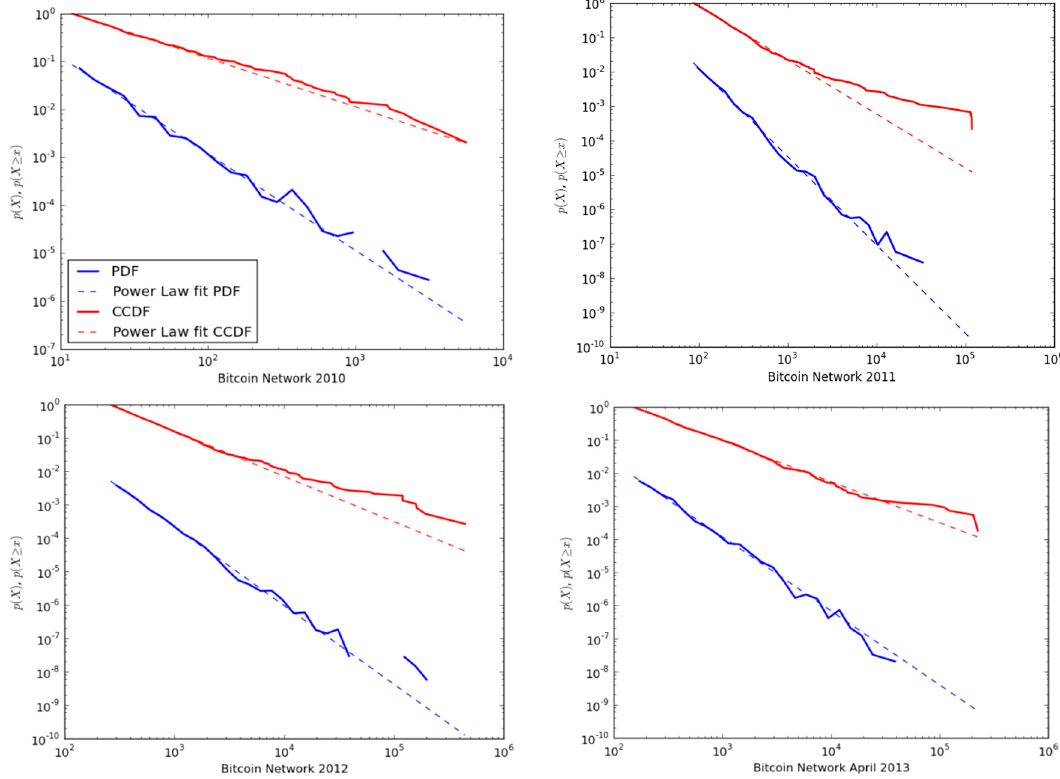
Figure 21. Degree Distribution (probability density function (PDF), complementary cumulative distribution function (CCDF)) over Time.